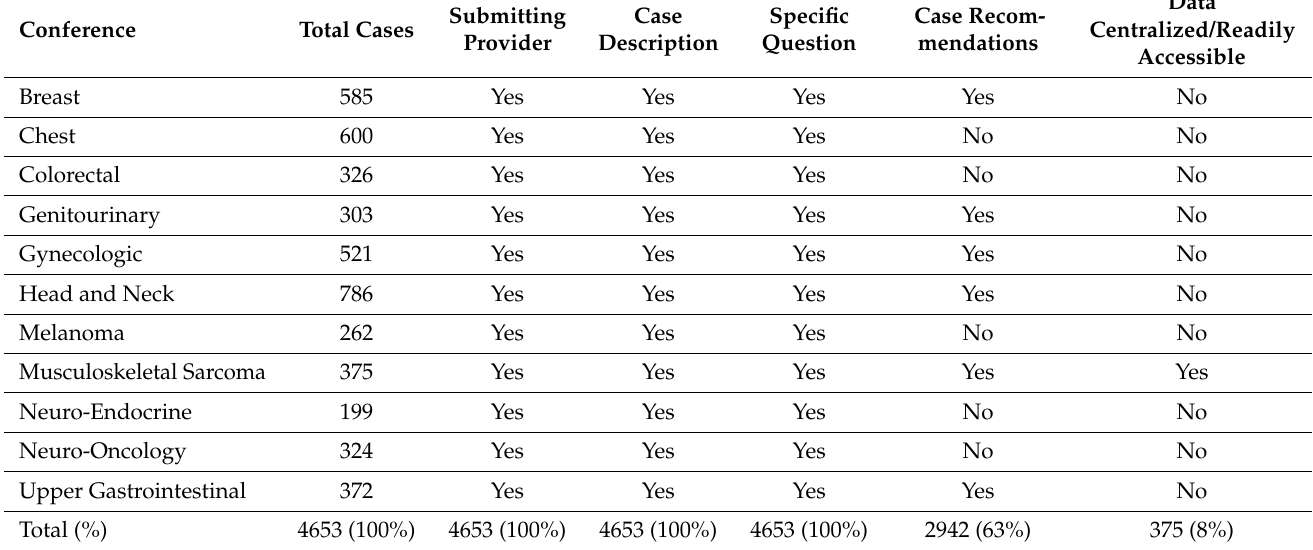
Table 3. Tumor board data collected for 11 Multidisciplinary Tumor Boards Over the 3 years: 1